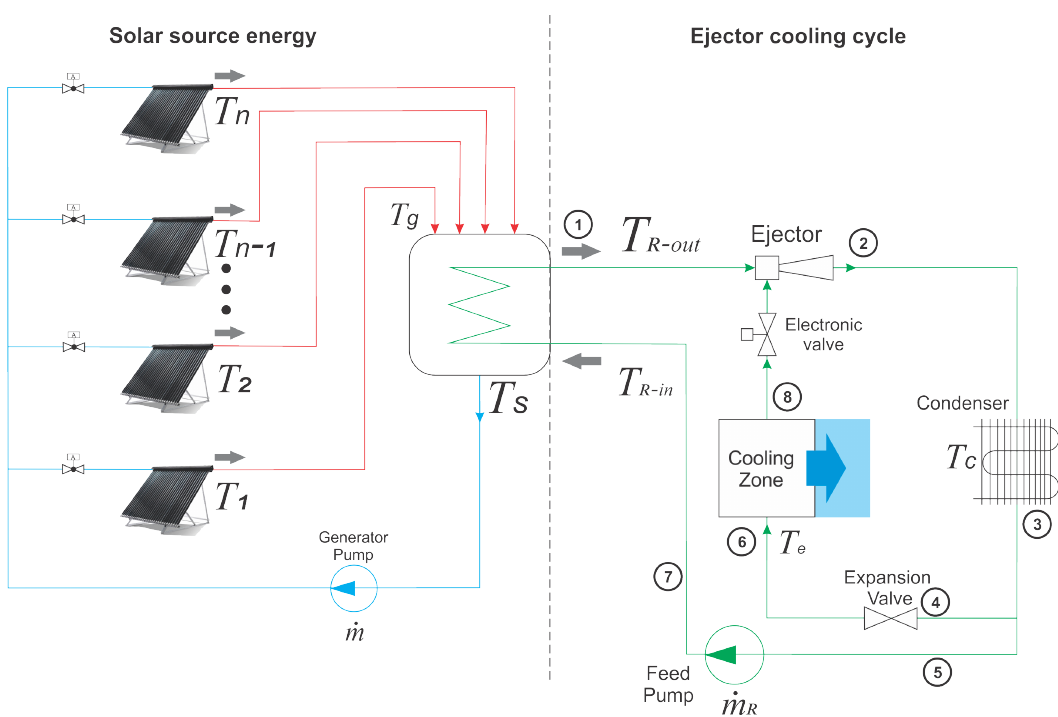
Figure 1. Structure of the solar thermal system of vacuum